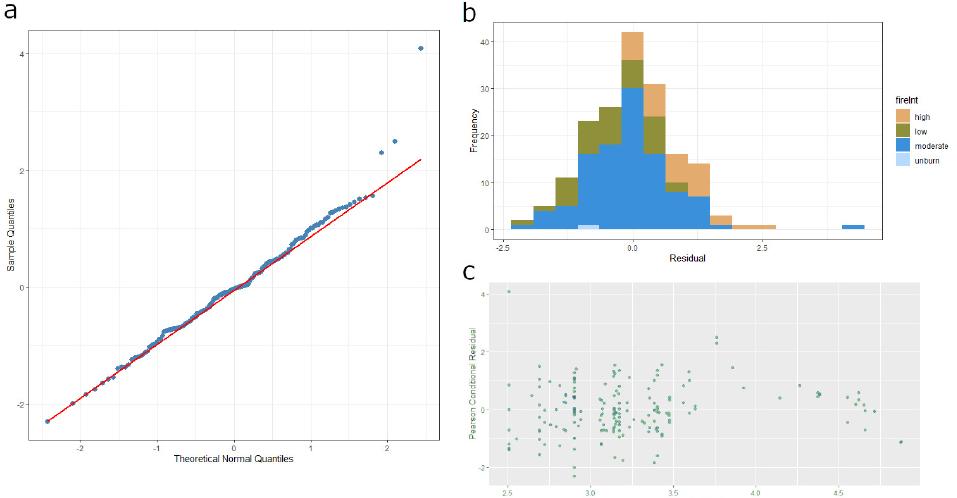
Figure 3. Diagnostic plots for the residuals of the proposed models: normal Q-Q plot comparing the probability distribution of the residuals with a normal distribution ( a ), histogram of the distribution of the residuals classified using the fire severity ( b ), and Pearson conditional residuals compared with the predicted value ( c ).